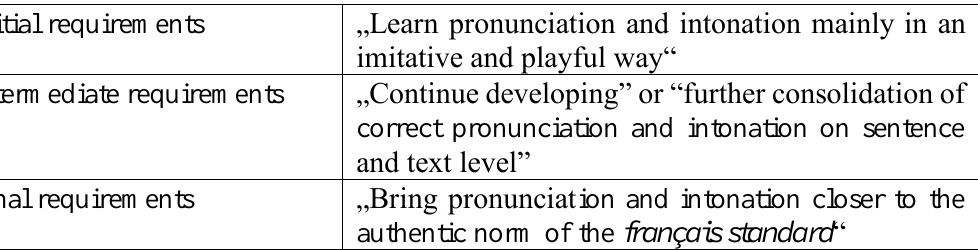
Table 1. Progression of requirements in Bavaria (for French; see Feldhausen 2021: 98 for references and further